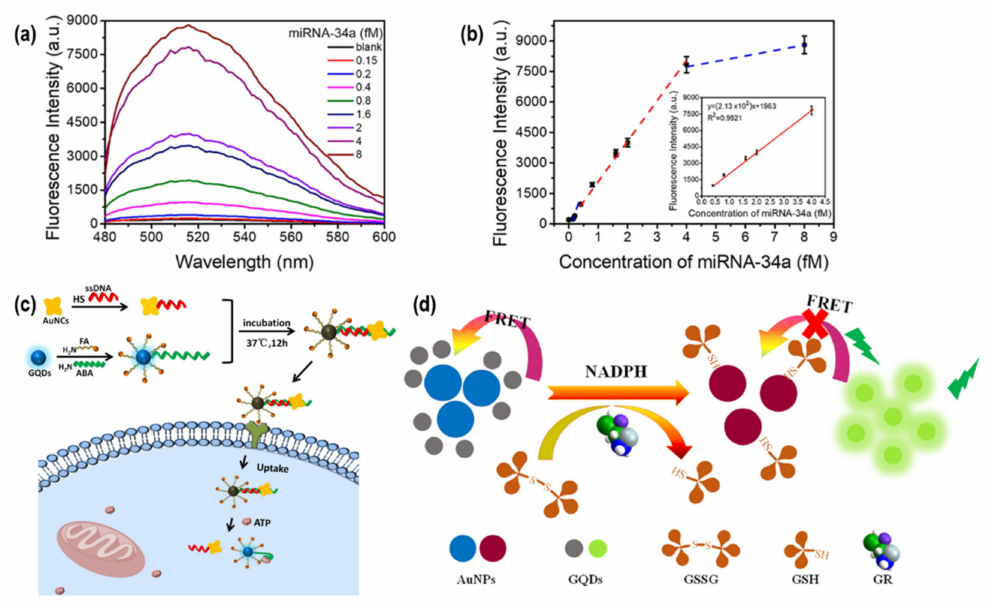
Figure 9. GQD nanocomposites as PL-based biosensors. ( a ) PL spectra and ( b ) the corresponding PL intensity of AuNF@GQDs in the presence of different concentrations of miRNA-34a [91]. The dashed lines in subfigure ( b ) represent the fluorescence intensity dependency on the miRNA-34a concentrations from 0 to 8 fM, while the solid line represents the linear detection range from 0.4 to 4 fM (inset). Schematic illustration of ( c ) the AuNCs-GQDs nanocomposites for intracellular-ATP sensing [92], and ( d ) GQDs-AuNPs nanocomposites for GR detection